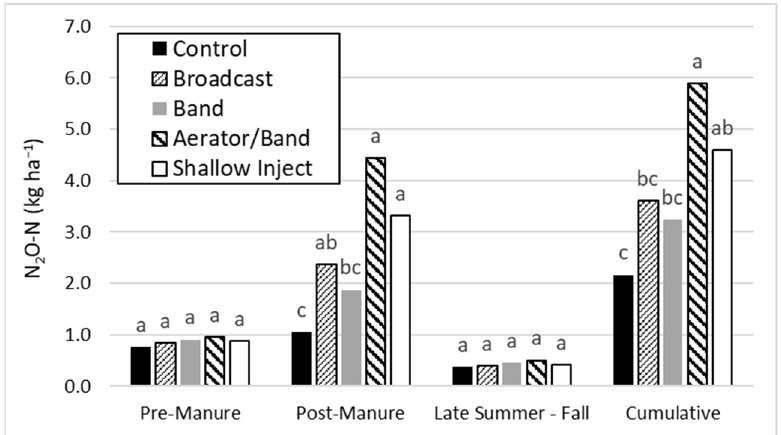
Figure 5. Mean cumulative (N 2 O-N) fluxes by season and mean total cumulative fluxes for the study. Means without a common lower case letter within each time period differ at p < 0.10.